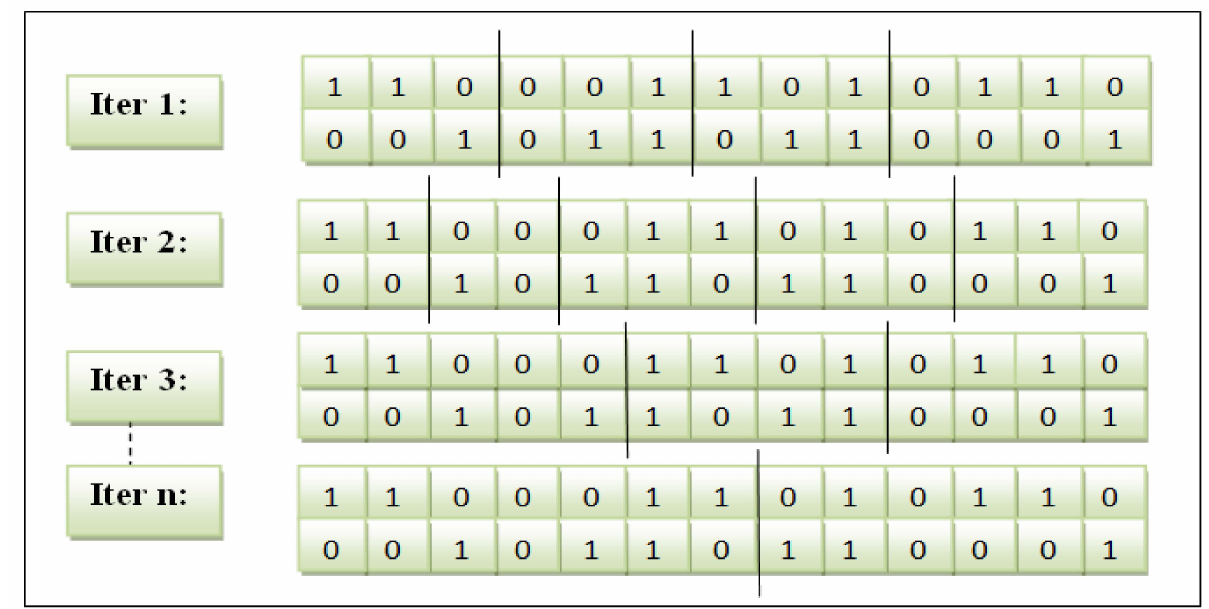
Figure 3. Proposed placeholder slice point for genes interchanging in the offspring generation